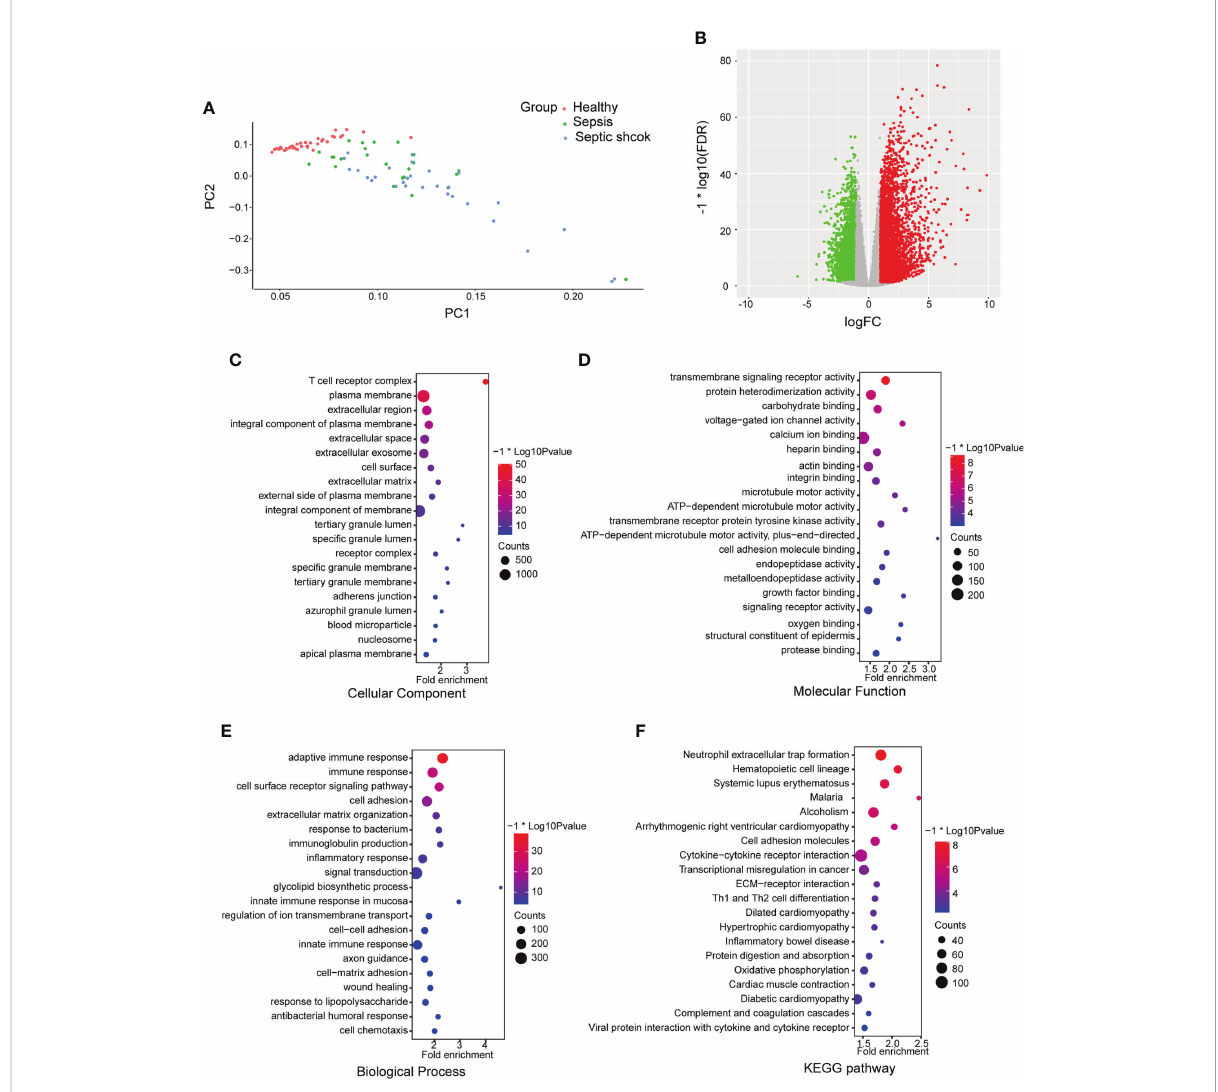
FIGURE 1 Differential mapping and functional enrichment analysis of sepsis in GSE154918. (A) Principal components analyses were performed on all samples in healthy, sepsis, and septic shock groups (B) Volcano plots of DEGs between healthy and sepsis (including septic shock). The enrichment analysis shows the top 20 items ranked by p -value. (C) GO analysis on cellular component (CC), (D) molecular function (MF), and (E) biological process (BP). (F) KEGG pathways. DEGs, differentially expressed genes; GO, Gene Ontology; KEGG, Kyoto Encyclopedia of Genes and